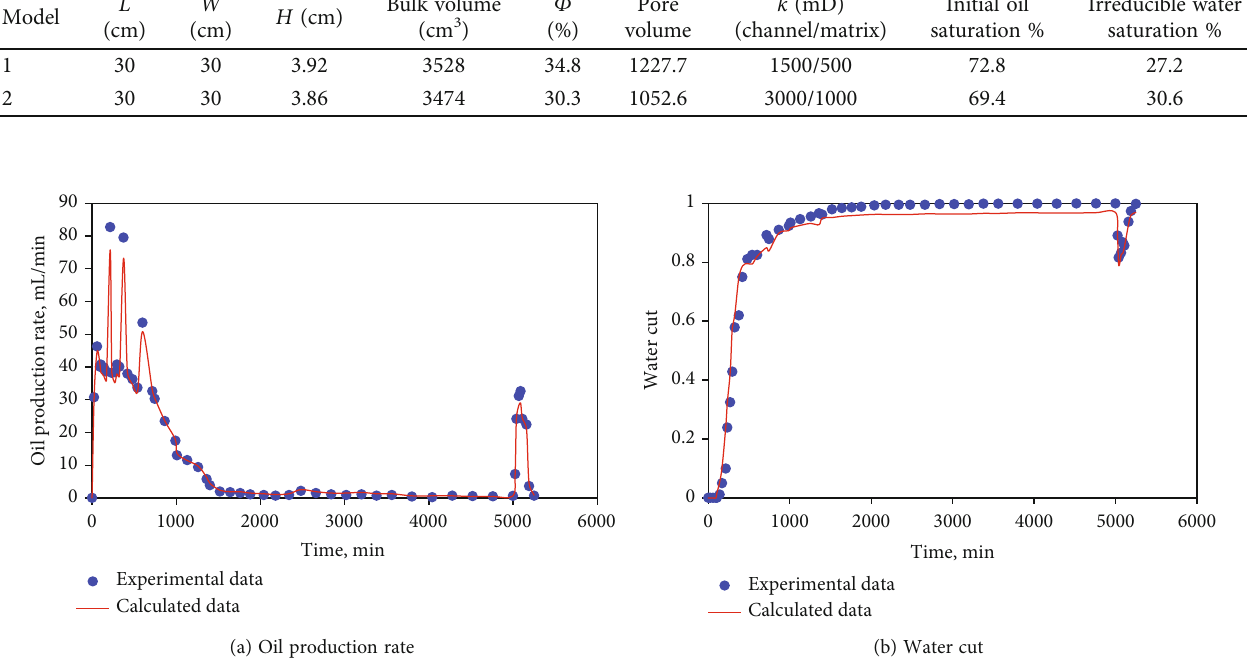
Figure 9: Oil production rate and water cut change after polymer pro fi le control.